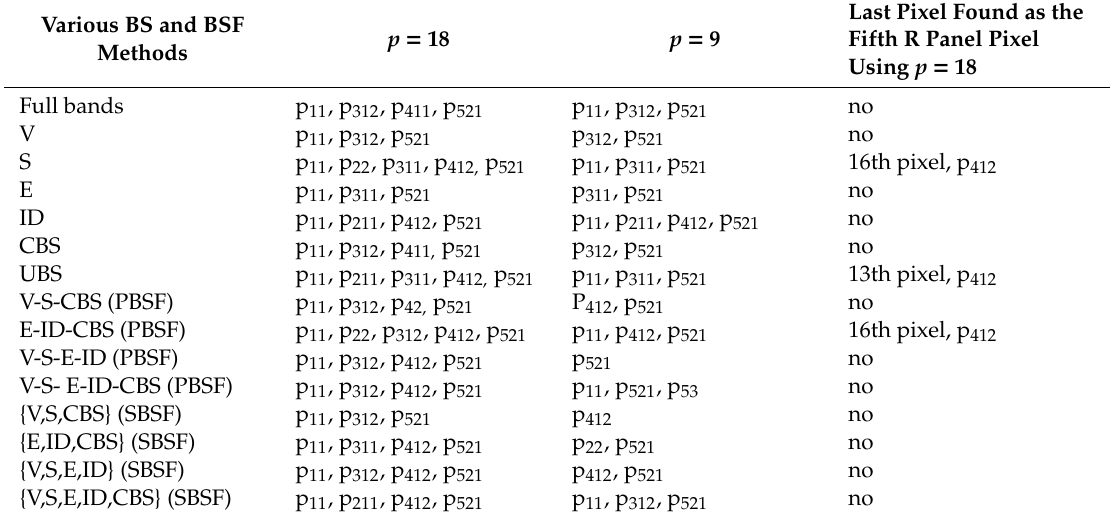
Table 4. Red panel pixels found by ATGP in Figures 1–3.